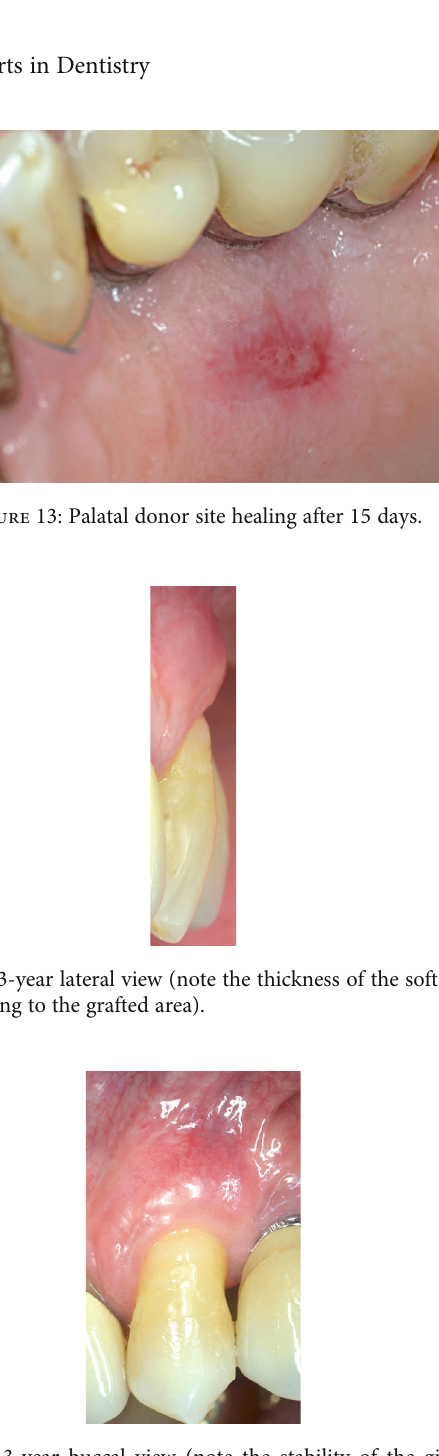
Figure 15: 3-year buccal view (note the stability of the gingival margin, the partial root coverage achieved and the aesthetic blending of the